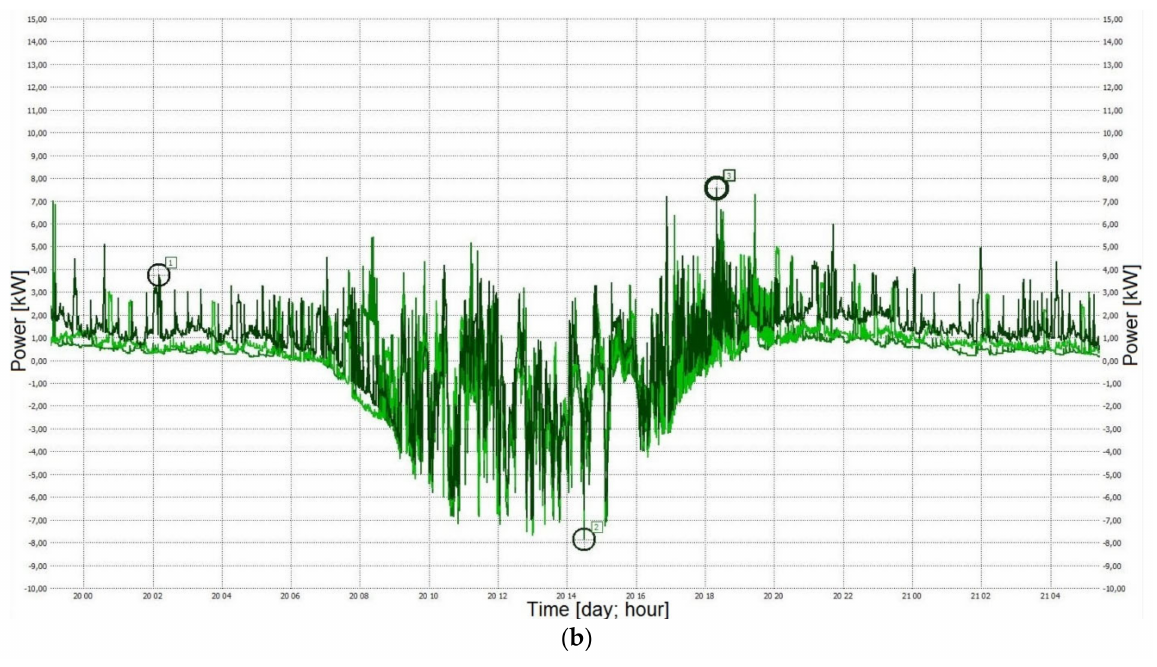
Figure 3. Voltage and active power variations in the supply substation (period: 20 May 2021, hour